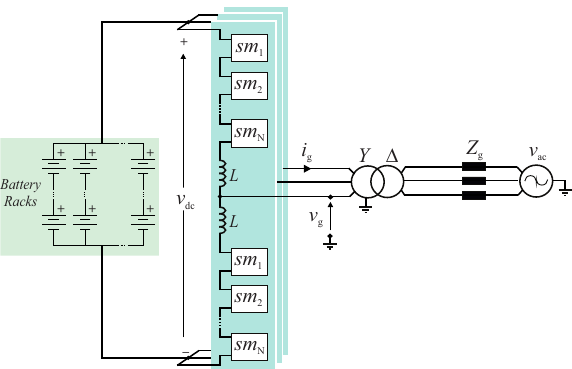
Figure 2. Schematic of the centralized energy storage (CES) topologies. Remark : DSCC-CES, DSBC-CES and DSHC-CES topologies differ only in the type of cell